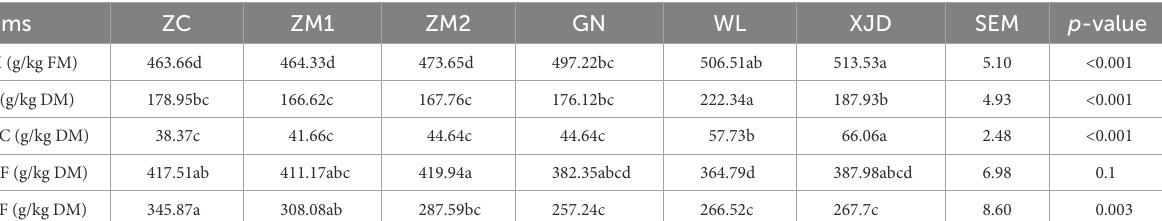
TABLE 1 Chemical composition of fresh alfalfa.